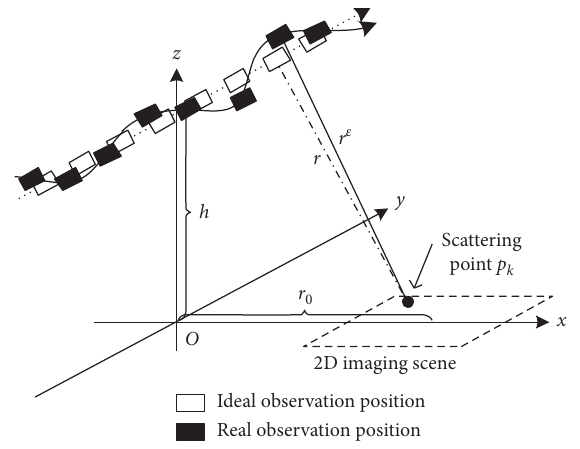
Figure 1: Imaging geometric